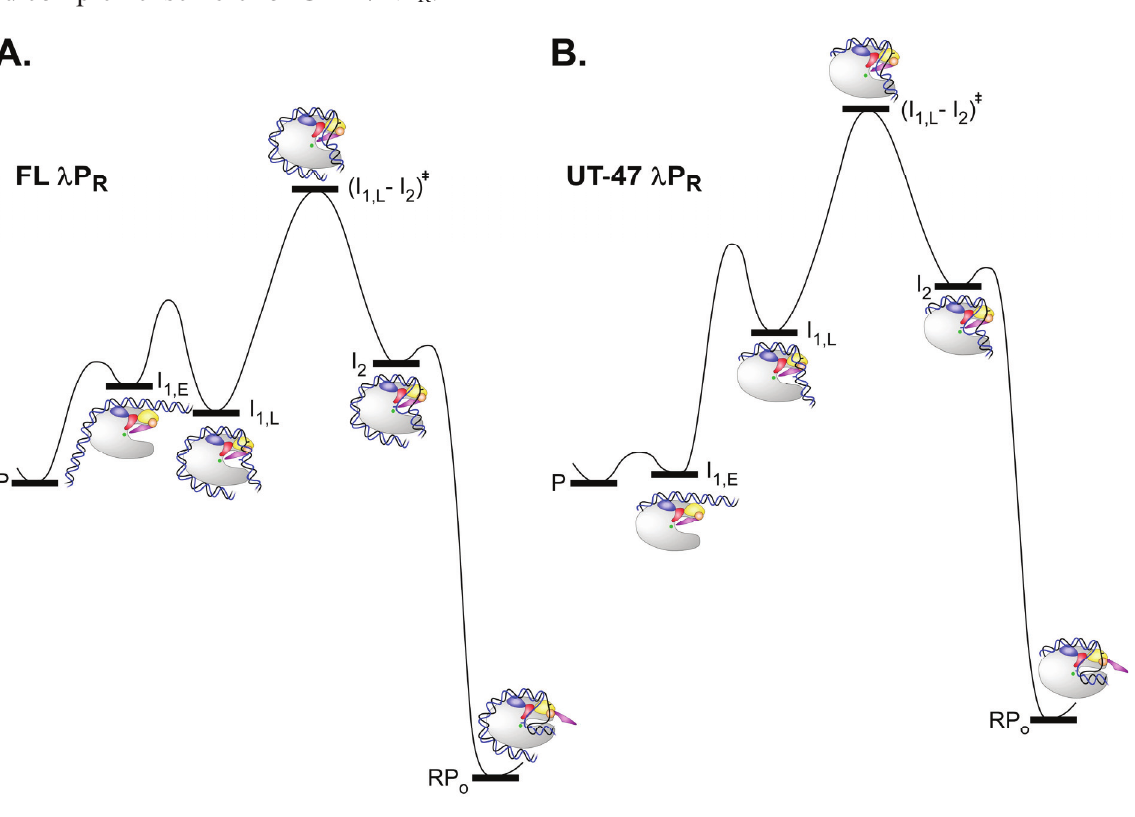
Figure 5. Reaction progress diagrams for open complex formation by ( A ) FL and ( B ) UT(cid:2)47 (cid:7)P R , interpreted using Mechanism 2. Free energies of the rapidly-equilibrating closed intermediates I 1,E and I 1,L , the rate- determining transition state (I 1,L -I 2 ) ‡ , and the initial (I 2 ) and stable (RP O ) open complexes are calculated relative to promoter DNA (P) for [R] = 30 nM from experimentally-determined values of K 1 , k 2 , k -2 and k d for FL (cid:7)P R [24,60] and UT-47 (cid:7)P R [75] at 37 °C (see text for details). Free energies of FL and UT-47 (cid:7)P R are set at the same value. For purposes of illustration, for both variants, we estimate that k open = 1 s (cid:2)1 and that (I 1,L -I 2 ) ‡ decomposition frequencies are 10 3 s (cid:2)1 in each direction, and assume that k -2 for UT-47 (cid:7)P R is the same as that determined for FL (cid:7)P R